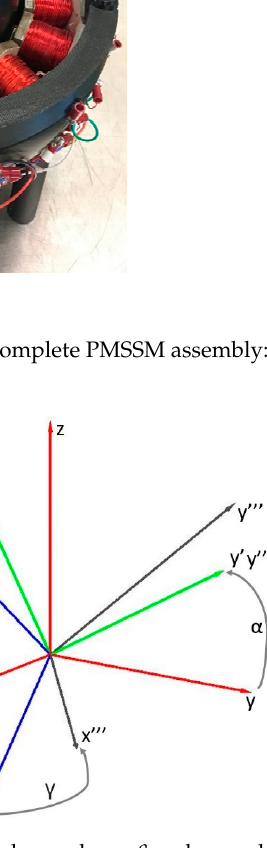
Figure 11. Euler angles α , β and γ used for quantifying angular rotor displacement.